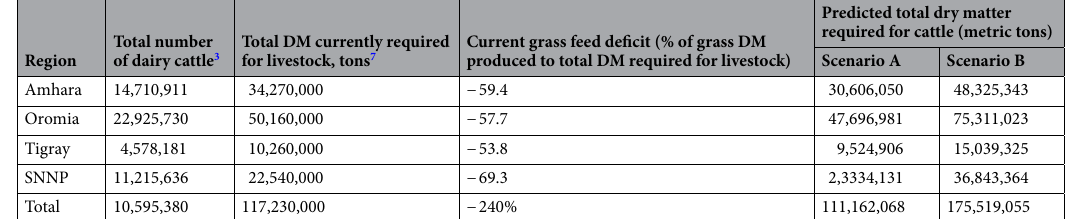
Current grass feed deficit (% of grass DM produced to total DM required for